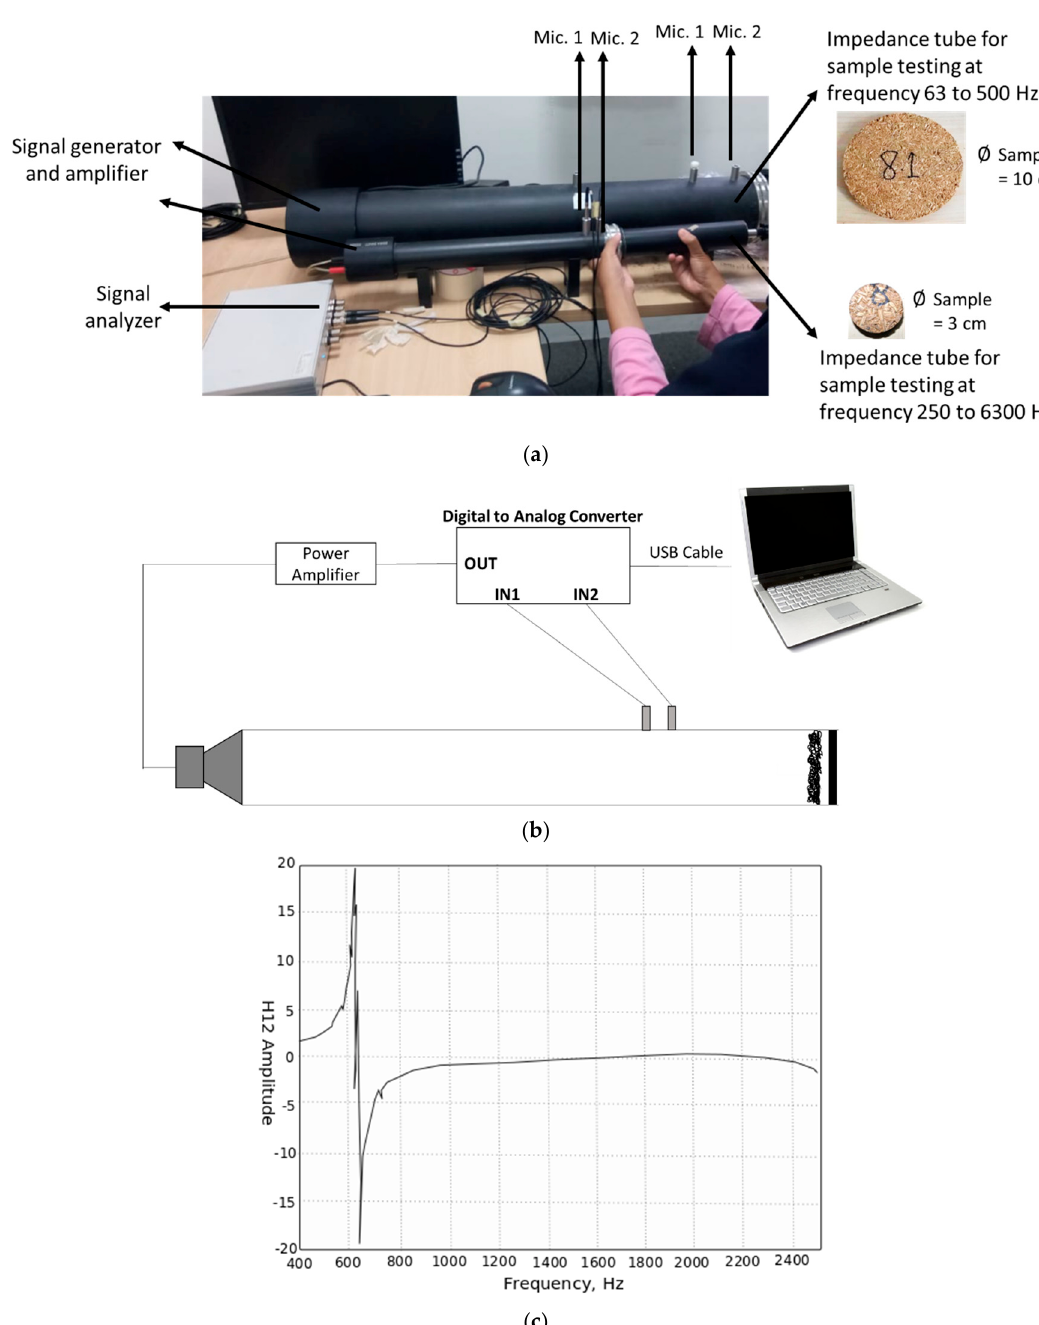
Figure 2. ( a ) Experimental testing of impedance tube for determination of sound absorption, ( b ) schematic of the impedance tube system, ( c ) transfer function signal from two microphones.